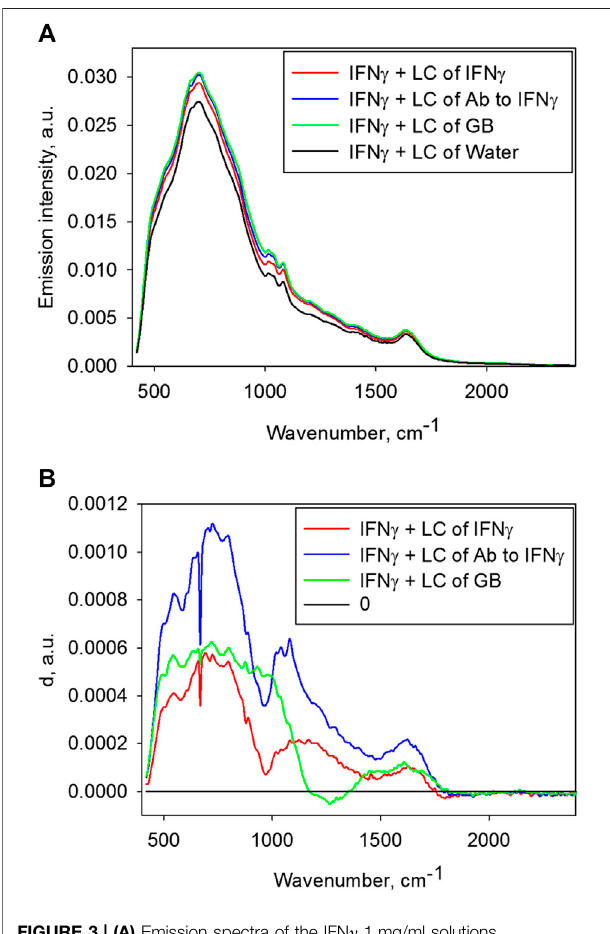
FIGURE 3 | (A) Emission spectra of the IFN γ 1 mg/ml solutions supplemented with the 10v% test samples or the control. (B) Paired comparisons of emission spectra of the IFN γ 1 mg/ml solutions supplemented with the 10v% test samples for detecting statistically signi fi cant differences from the IFN γ 1 mg/ml solution supplemented with the control according to formula (2).